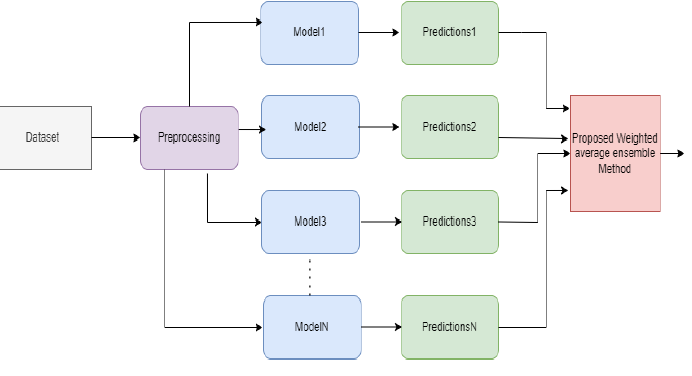
Figure 6. Proposed